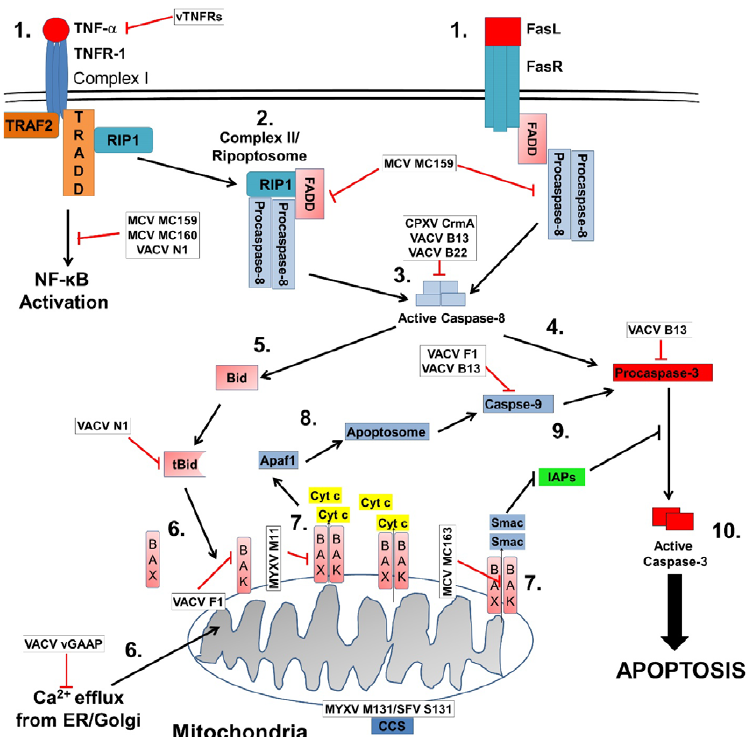
Figure 1. Overview of the extrinsic and intrinsic apoptotic pathways. ( 1 ) Tumor necrosis factor α ( TNFα ) or the Fas ligand (FasL) bind to the respective TNF-receptor (TNFR)-1 or FasR receptors. Fas-associated death domain protein (FADD) binds to the cytoplasmic region of FasR and forms a scaffold that recruits procaspase-8.For TNF, TNFR-associated death domain protein (TRADD) associates with the cytoplasmic death domain (DD) of the TNF-R1 and forms complex 1 which leads to nuclear factor κ B (NF- κ B) activation; ( 2 ) Alternatively, TNF can induce apoptosis when receptor-interacting protein 1 (RIP1) forms a cytoplasmic complex II consisting of RIP1, FADD, and procaspase-8; ( 3 ) Procaspase-8 oligomerization results in its autocleavage and activation where the initiator caspase-8 activates ( 4 ) caspase-3 or cleave additional substrates such as ( 5 ) BH3 interacting-doain death agonist (Bid) to truncated (t)Bid; ( 6 ) tBid activates Bcl-2 homologous antagonist killer (Bak)/Bcl-2-associated X protein (Bax) oligomers in the mitochondria. Alternatively, Bak/Bax can form pores in the mitochondria outer membrane in response to Ca 2+ efflux from the endoplasmic reticulum (ER) or Golgi; ( 7 ) Bax/Bak pores result in mitochondria membrane permeabilization which leads to the subsequent release of cytochrome c and second mitochondria-derived activator of caspases/direct inhibitor of apoptosis protein with low pI) (Smac/DIABLO, referred to as “Smac” in the illustration) from the inner membrane space of the mitochondria to the cytosol; ( 8 ) Cytoplasmic cytochrome c binds Apaf1 leading to the formation of the apoptosome and the activation of initiator caspase-9; ( 9 ) caspase-9 in turn activates effector caspases such as caspase-3.Smac released form the mitochondria also binds inhibitor of apoptosis proteins (IAPs) which allows caspase-3 to become active and cleave target proteins; ( 10 ) Effector caspases in turn cleave target proteins resulting in the activation of apoptosis. Poxvirus proteins are indicated in the open boxes. Red lines indicate points in the pathway inhibited by viral proteins. Vaccinia virus (VACV) F1, Myxoma virus (MYXV) M11, MYXV M131, Shope Fibroma Virus (SFV) S131, and Molluscum Contagiosum Virus (MCV) MC163 localize to the mitochondria where these proteins antagonize mitochondria mediated responses in the intrinsic apoptotic pathway. MYXV M131/SFV S131 are depicted interacting with cellular copper chaperones for superoxide dismutase